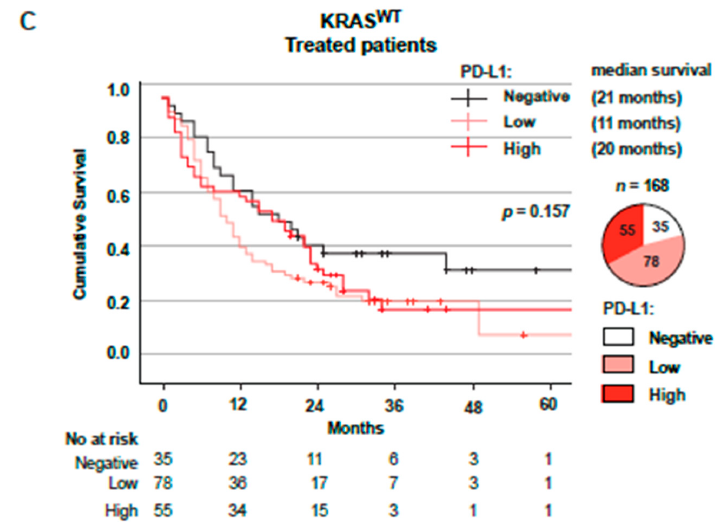
Figure 4. PD-L1 status has an impact on overall survival for treated patients with KRAS MUT . ( A ) IHC depicting examples of PD-L1 staining used to assess PD-L1 status in both KRAS WT and KRAS MUT NSCLC patients. PD-L1 expression is classified as negative, <50% or ≥ 50% based on tumor proportion score. ( B ) Kaplan–Meier estimates comparing overall survival for KRAS MUT treated patients stratified on PD-L1 status. Pie chart showing patient distribution between PD-L1 negative, <50% and ≥ 50%. ( C ) Kaplan–Meier estimates comparing overall survival for KRAS WT treated patients stratified on PD-L1 status. Pie chart showing patient distribution between PD-L1 negative, <50% and ≥ 50%. IHC: Immunohistochemistry; PD-L1: Programmed death ligand 1. Scale bar: 100 µ m.